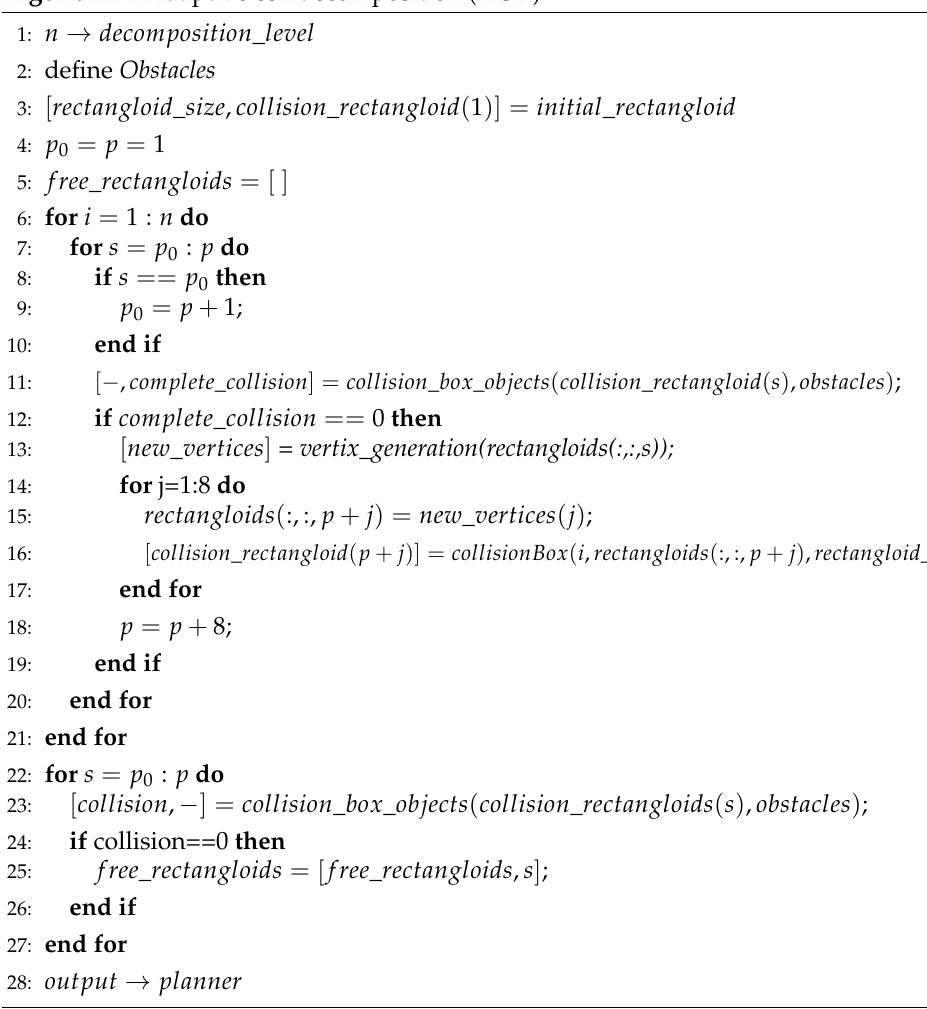
Algorithm 1 Adaptive cell decomposition